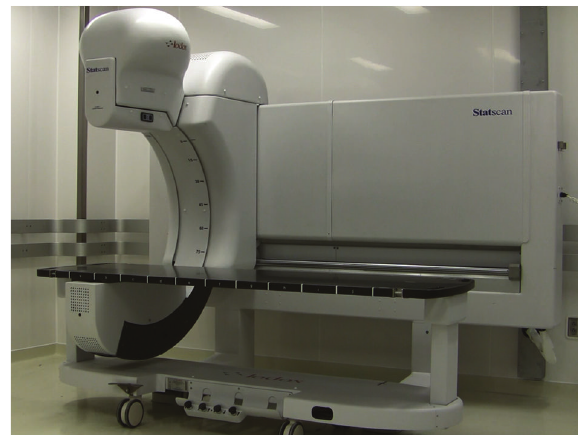
Figure 1: The Lodox Statscan